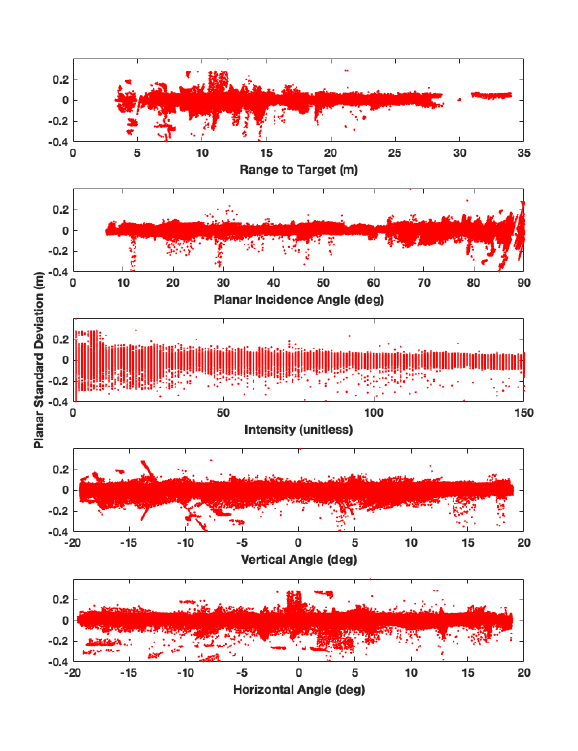
Figure 6. Livox Mid-40 Planar Residuals Standard Deviations Plotted Versus Range, Incidence Angle, Intensity, Horizontal Angle and Vertical Angle